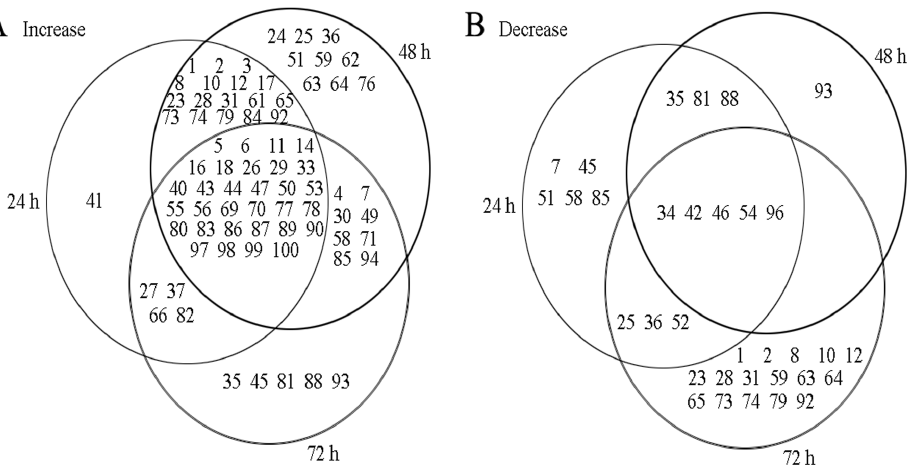
Figure 3. Venn diagram showing differential abundance of proteins that exhibited a significant ( P , 0.05) increase (A) or decrease (B) due to heat stress in alfalfa. Overlapping regions of the circles indicate proteins that were regulated in either the same manner in the respective treatment, whereas non-overlapping circles indicate proteins regulated in only that treatment.